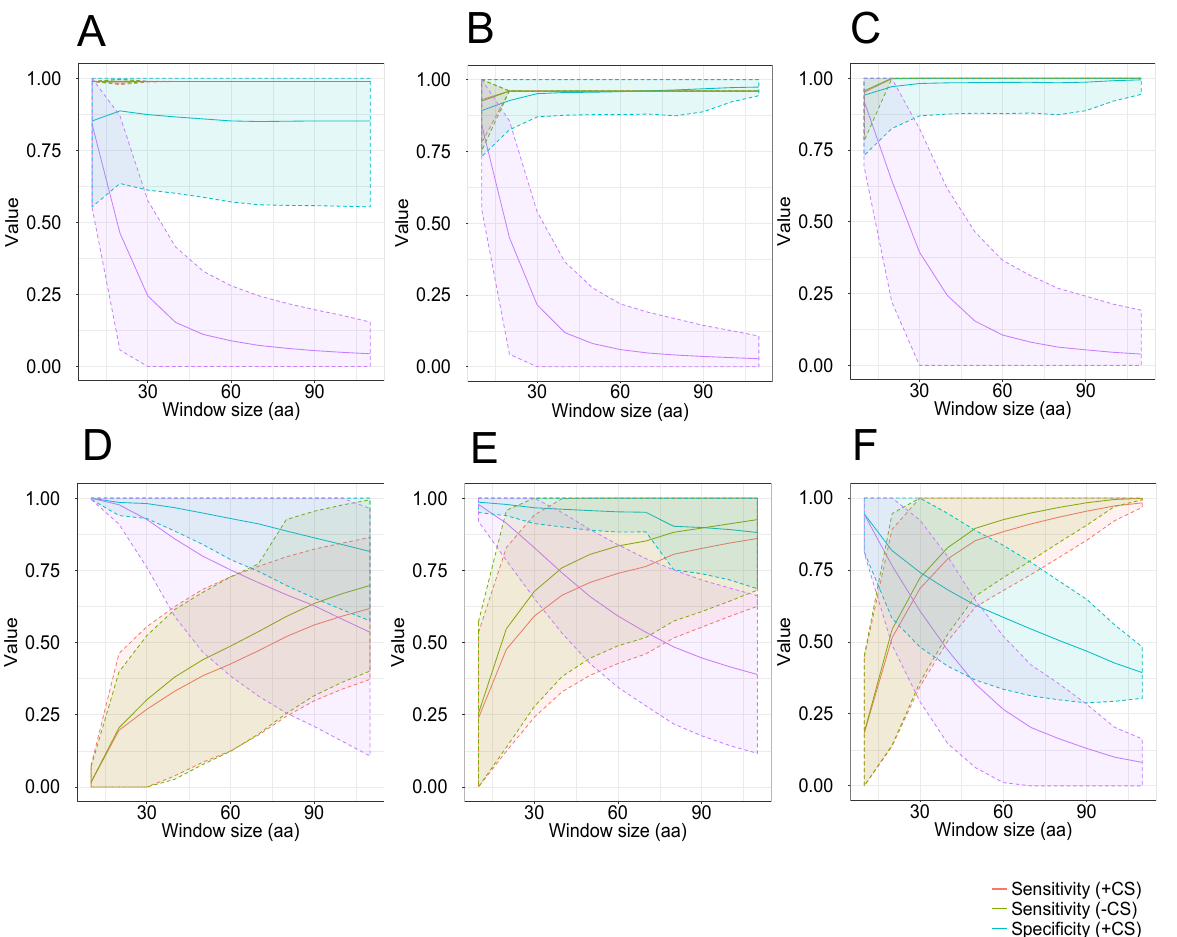
Figure 2. Evaluation of a complete repertoire of alignment blocks of variable size as candidates for the construction of discriminative profile HMMs. Sliding windows of different sizes, starting from a minimum length of 10 aa, and varying in increments of 10 aa each, were used throughout MSAs of full-length polyprotein sequences specific for DENV ( A ), ZIKV ( B ) and YFV ( C ) ( Flavivirus genus) or alignments of major capsid protein (VP1) sequences specific to Alpavirinae ( D ), Gokushovirinae ( E ) and Pichovirinae ( F ) subfamilies ( Microviridae family). Alignment blocks representing the entire repertoire obtained for each window size, were used to construct profile HMMs. All Flavivirus -derived models were tested with hmmsearch program against a bona fide dataset of 6364 Flavivirus sequences comprising a wide variety of viral species. For Microviridae , profile HMMs were validated against a bona fide dataset of 1836 VP1 sequences, comprising members of three subfamilies of this family. Sensitivity and specificity lines, using (+CS) or not (-CS) cutoff scores, represent arithmetic means calculated from the combined values of the multiple models generated for each alignment block size. Shaded areas indicate standard deviation values. Cutoff scores correspond to 80% of the alignment score observed for the lowest hit detected by each individual model against the corresponding training